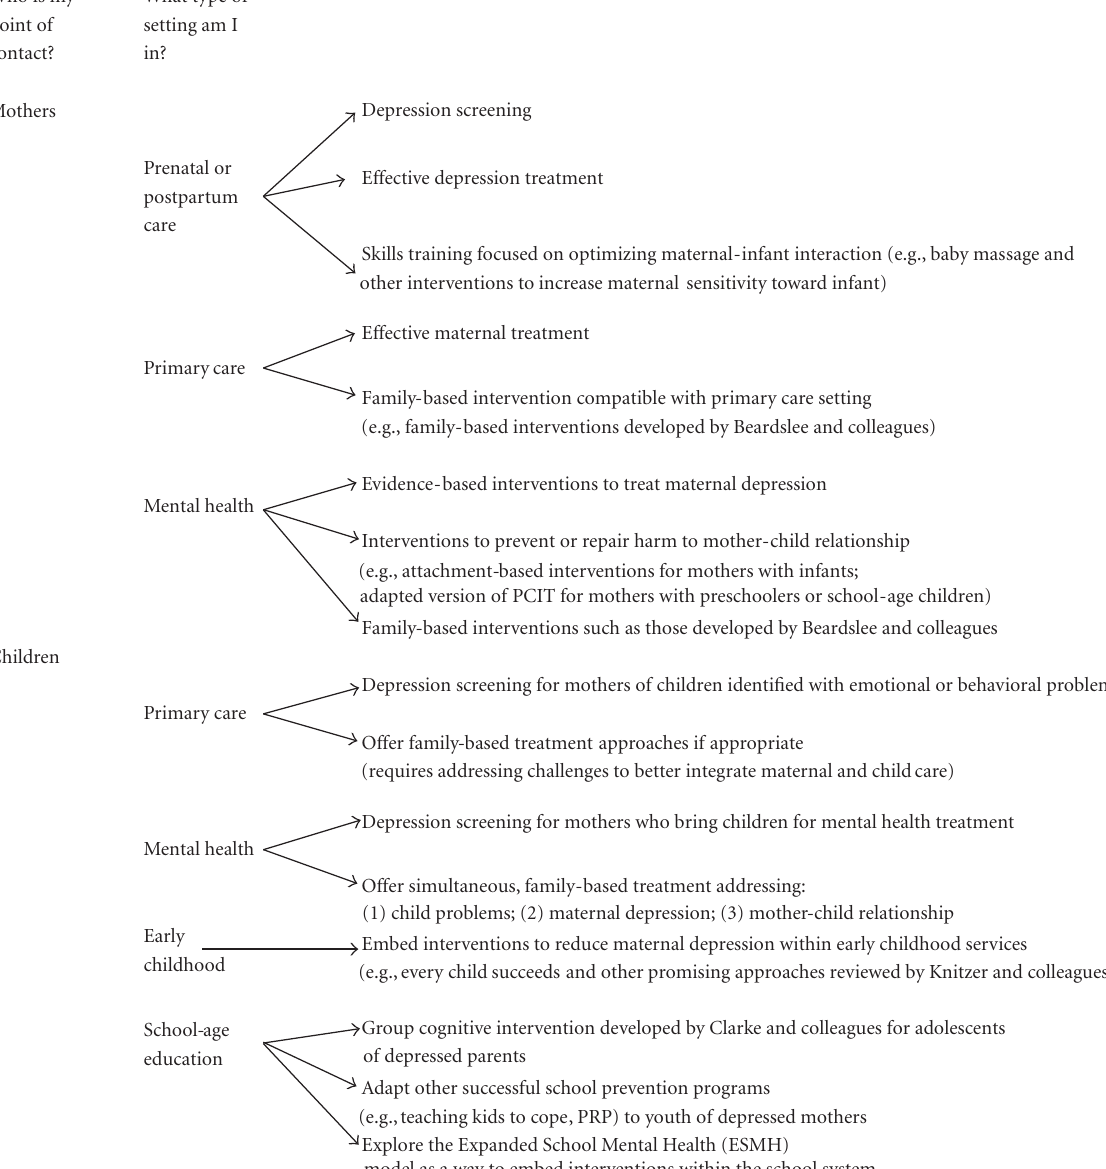
Figure 1: Practitioner-based flow chart to identify pathways to prevention for children of depressed